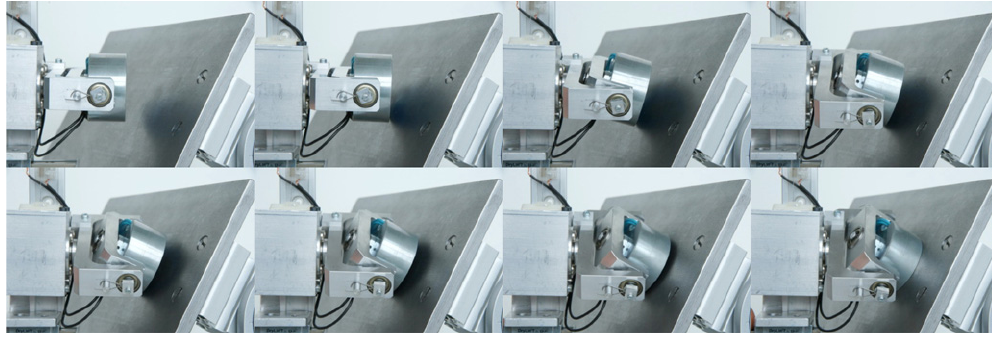
Figure 8. Wrist joint passive alignment.